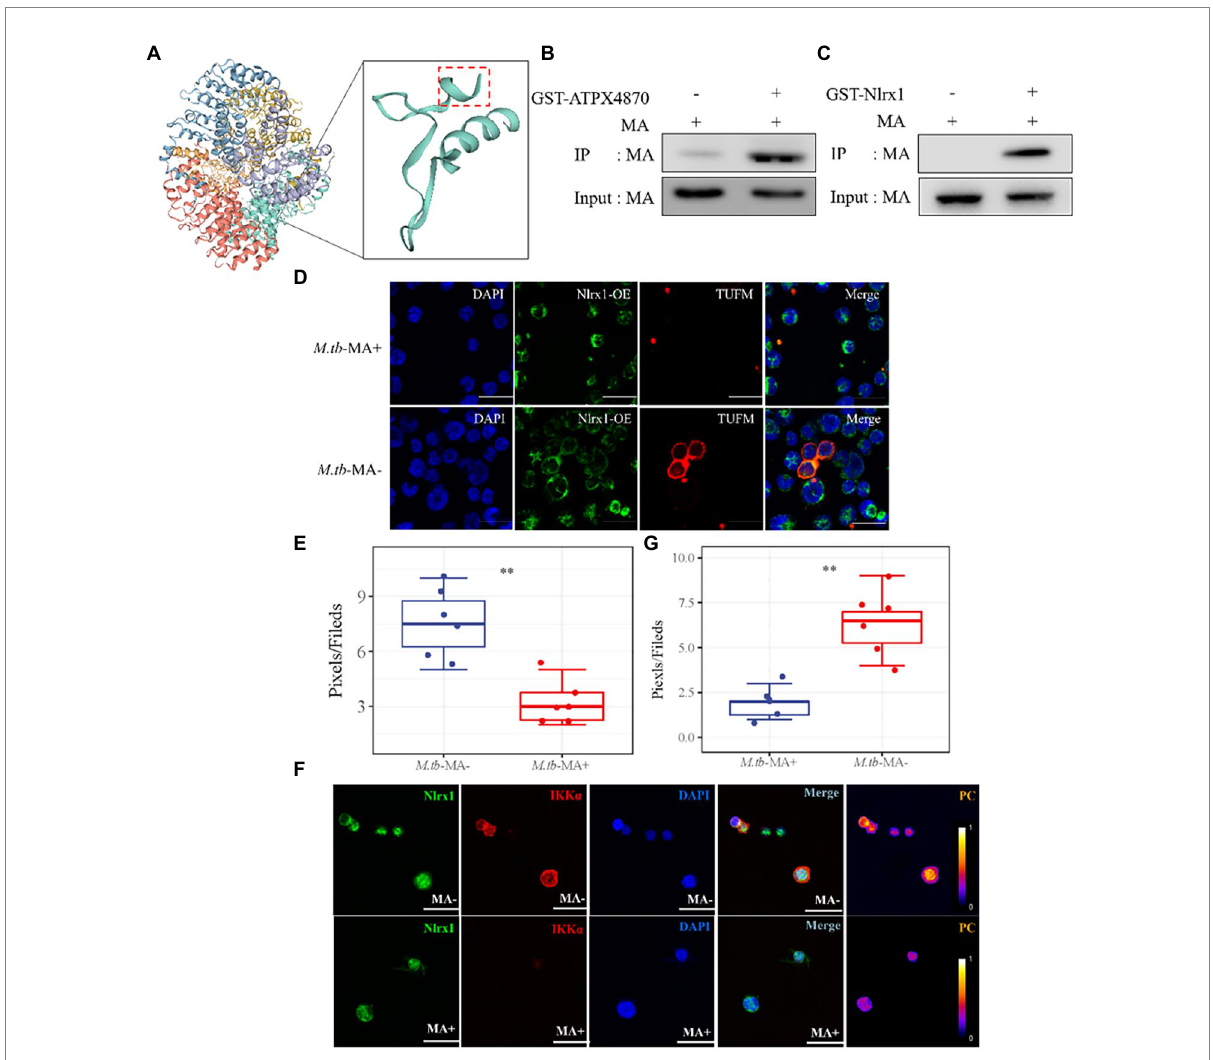
FIGURE 7 Peptides exert function by inhibiting the binding of M.tb -MA and Nlrx1. (A) Schematic of Nlrx1 protein structure and the APTX4870 homologous sequence. (B,C) GST-pull down assay. GST-APTX4870 or GST-Nlrx1 was incubated with M.tb -MA for 3–5 h and then pulled down with GSH beads. The precipitates were subjected to immunoblot and probed with M.tb -MA antibody ( n = 3). (D,E) The expression of Nlrx1 and TUFM was analyzed by immunofluorescence cytochemistry. Nlrx1 was visualized in green, TUFM was visualized in red and DAPI-stained nuclei in blue. Scale bars: 50 μ m. Results from one experiment, representative of three independent experiments ( n = 6) are shown. Quantitative the expression of TUFM by optical densitometry assay using ImageJ Software version 1.46. Data were presented as mean ± SD, ** 0.01 < p < 0.05: M.tb -MA+ vs. M.tb -MA-. (F,G) The expression of Nlrx1 and IKK α was analyzed by immunofluorescence cytochemistry. Nlrx1 was visualized in green, IKK α was visualized in red and DAPI-stained nuclei in blue. Scale bars: 50 μ m. Results from one experiment, representative of 3 independent experiments ( n = 6) are shown. Quantitative the expression of IKK α by optical densitometry assay using ImageJ Software version 1.46. Data were presented as mean ± SD, ** 0.01 < p < 0.05: M.tb -MA+ vs. M.tb